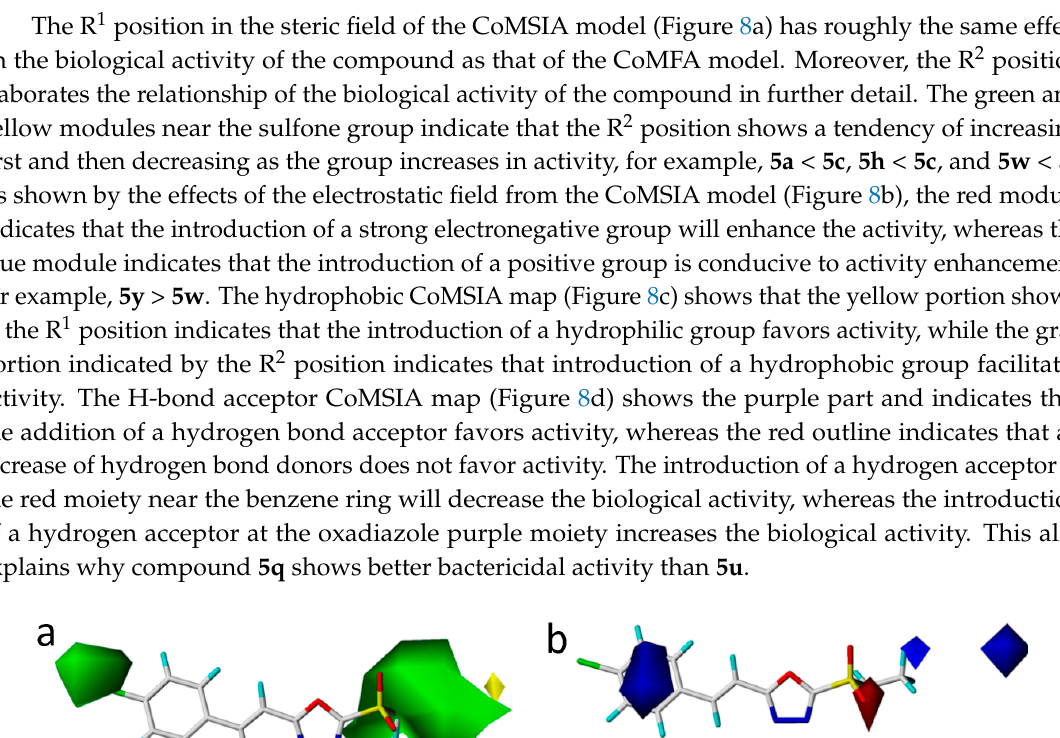
Figure 7. CoMFA contour maps of steric ( a ) and electrostatic ( b ) fields.